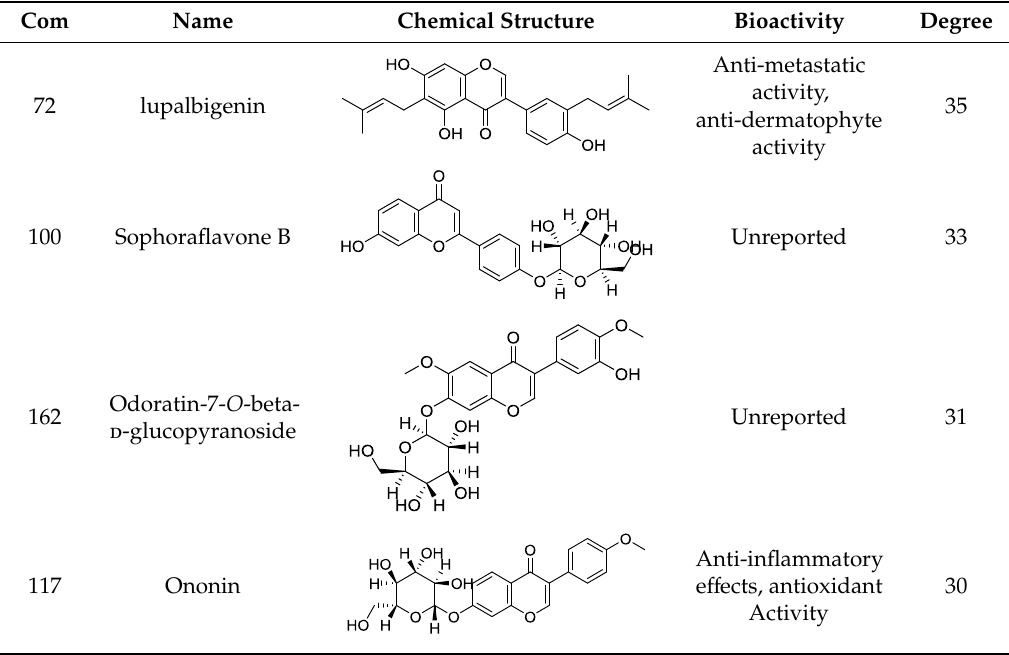
Figure 2. Degree distribution between compounds and putative targets. Table 3. Four compounds with top 4 degree distribution between compounds and putative targets.